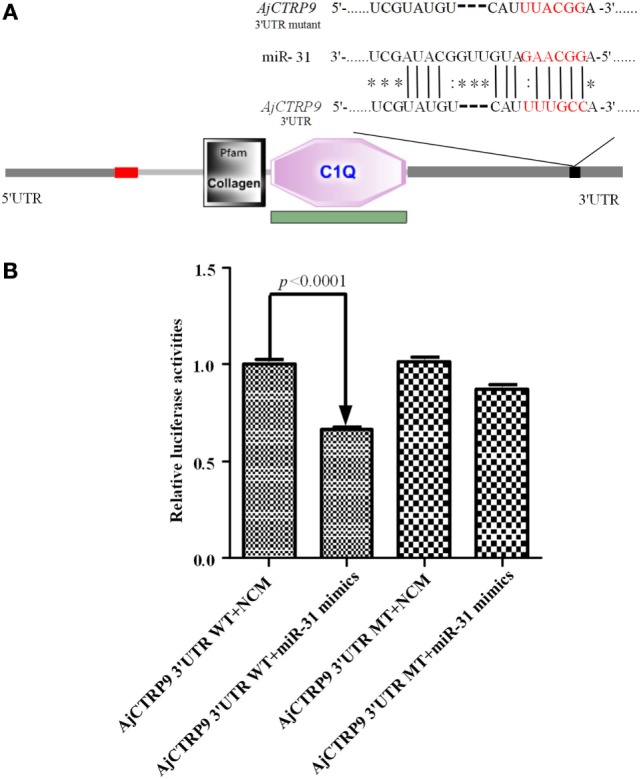
Identification and characterization of the miR-31 binding sites in the 3’-untranslated region (3’-UTR) of AjCTRP9. (A) Schematic representation of putative miR-31 binding sites in the AjCTRP9 3’-UTR and the mutant sites (the protein domain of AjCTRP9 was annotated with SMART at http://smart.embl.de/), the red letters represent “seed” regions. (B)
AjCTRP9 luciferase reporter assays conducted in HEK-293T cells carrying the wild-type AjCTRP9 3’-UTR and a mutant AjCTRP9 3’-UTR (final concentration: 100 nM).